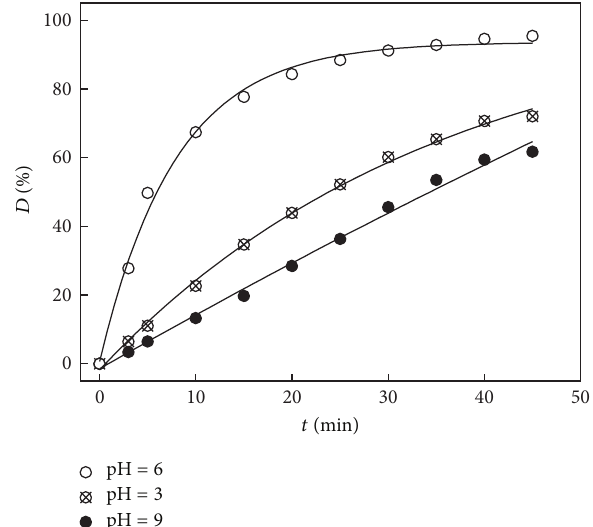
Figure9:DegradationofRR195withFe-AO-n-PANindifferentpH levels.